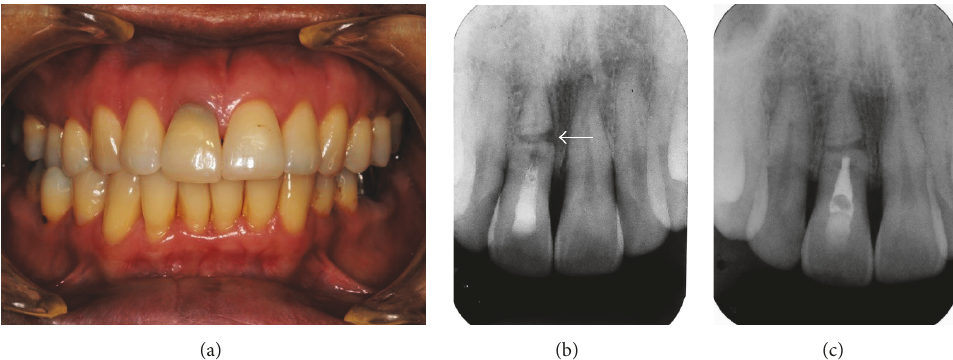
Figure 1: (a) Initial intraoral photograph (June 2012) reveals tooth discoloration and slight extrusion of tooth 11. (b) Initial periapical radiograph of tooth 11 (June 2012) reveals a middle-third horizontal root fracture and underfilled root canal medication. Discontinuation of lamina dura with a radiolucent area is noticed on the mesial aspect of the fracture site (arrow). (c) The periapical radiograph one year after medication with Vitapex (June 2013) shows improved healing. A continuous lamina dura is seen on both sides of the fracture and the apical fragment appears within normal